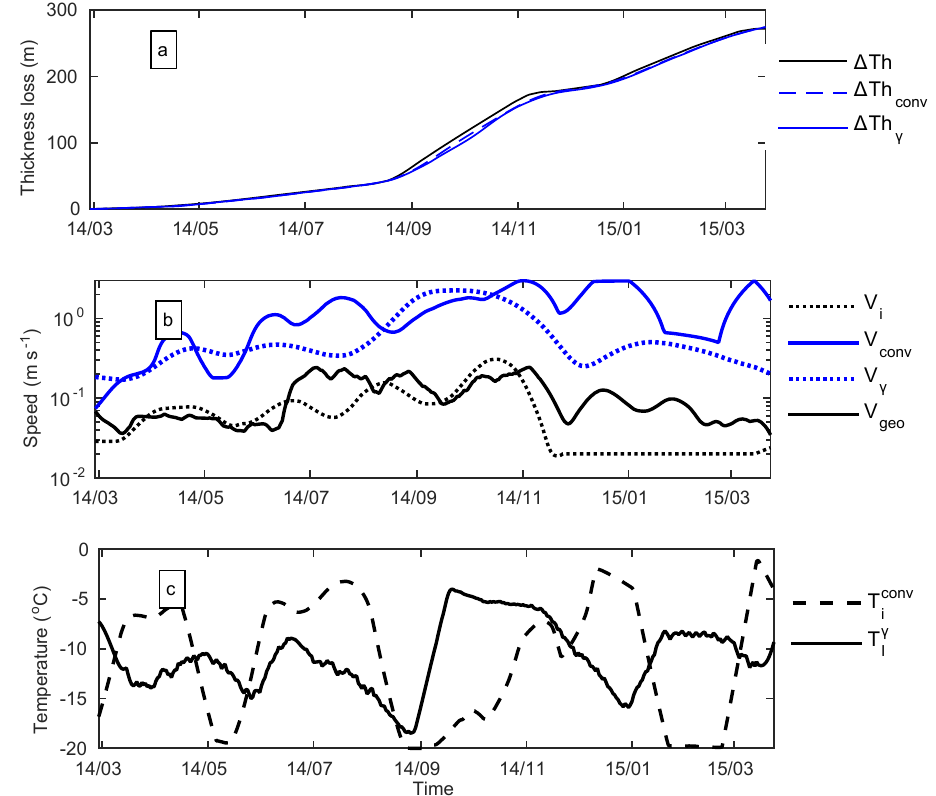
Figure 6. Thickness loss (in m) for B17a (a) . Measured thickness loss (black line); modelled loss using forced convection (dashed blue line) and turbulent exchange (solid blue line). (b) Iceberg velocity (dotted black line). Modelled velocity using forced convection (solid blue line) and using turbulent exchange (dotted blue line). AVISO Geostrophic current velocity (solid black line). (c) Modelled iceberg temperature using forced convection (dashed line) and using thermal exchange (solid